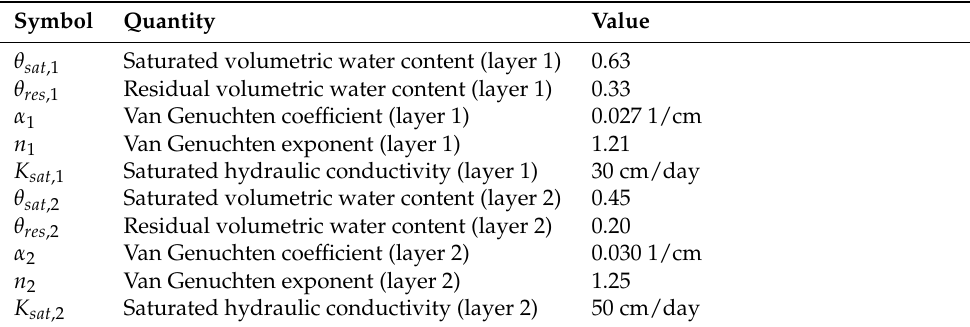
Table 1. Hydraulic parameters used for the synthetic infiltration